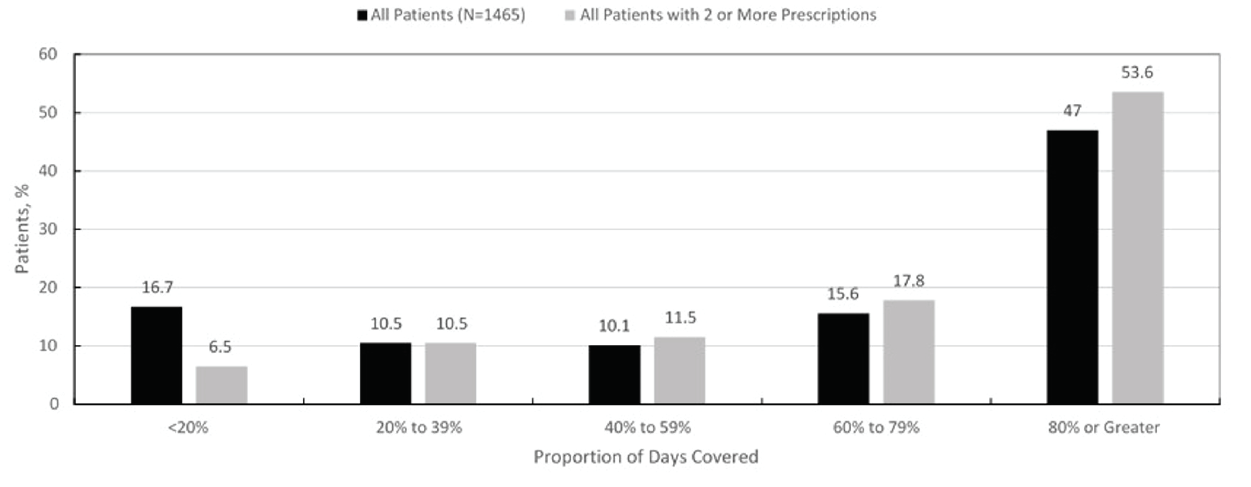
First Hospitalization for PAH